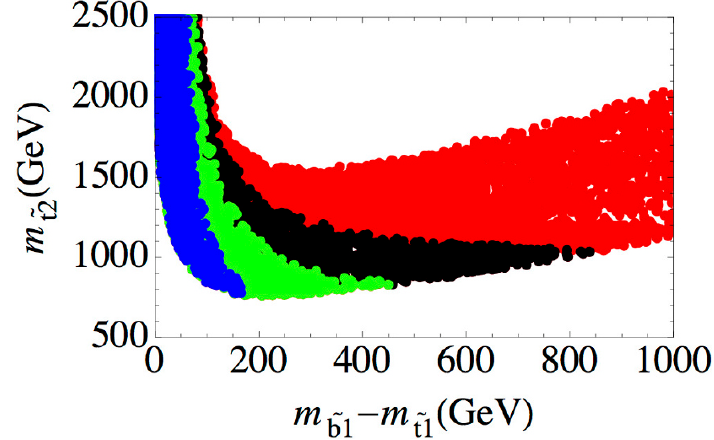
Figure 5 . m ~ as a function of the mass splitting m ~ t 2 and m ~ < 1 TeV in the MSSM. Red, black, green, and blue regions correspond to sbottom masses t 1 m ~ > 1000 ; 750 < m ~ < 1000 ; 500 < m ~ b 1 b 1